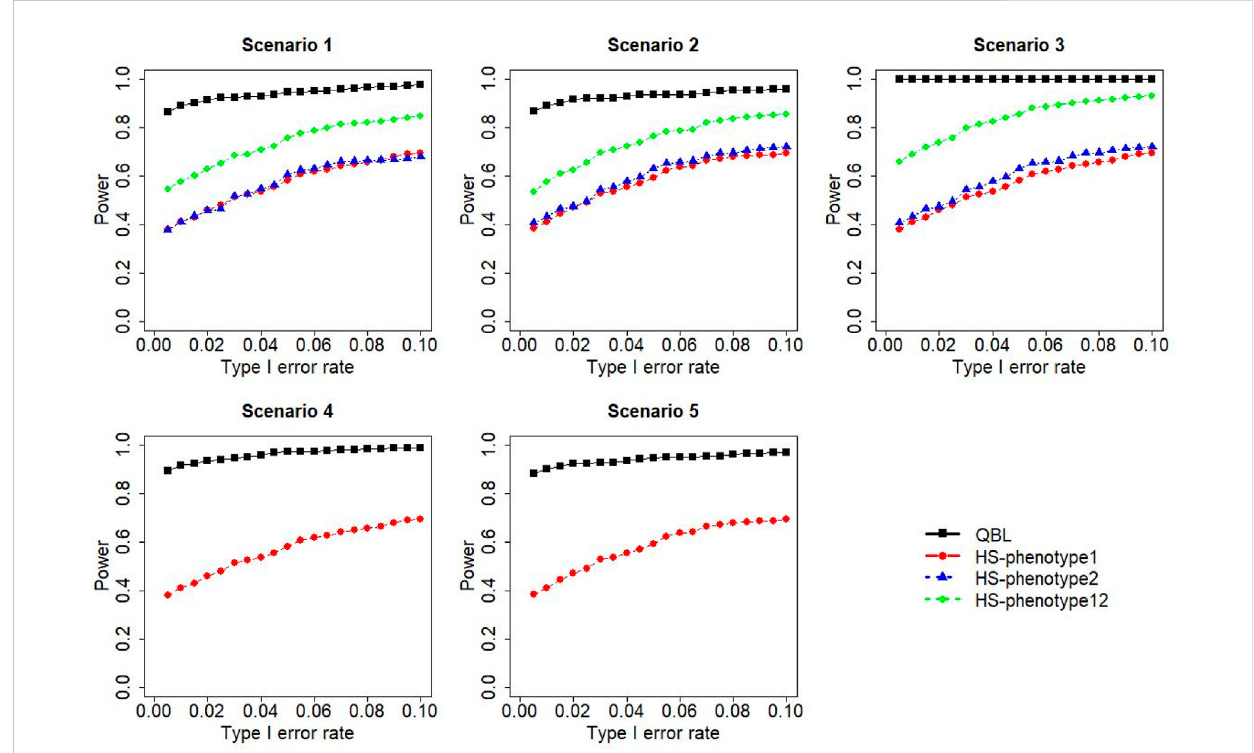
FIGURE 11 Simulation results under sample size 1,000, setting 2 (12 haplotypes), and ρ = 0.5. Scenarios are shown in Table 1. HS, Haplo.score; phenotype12: phenotype 1 or